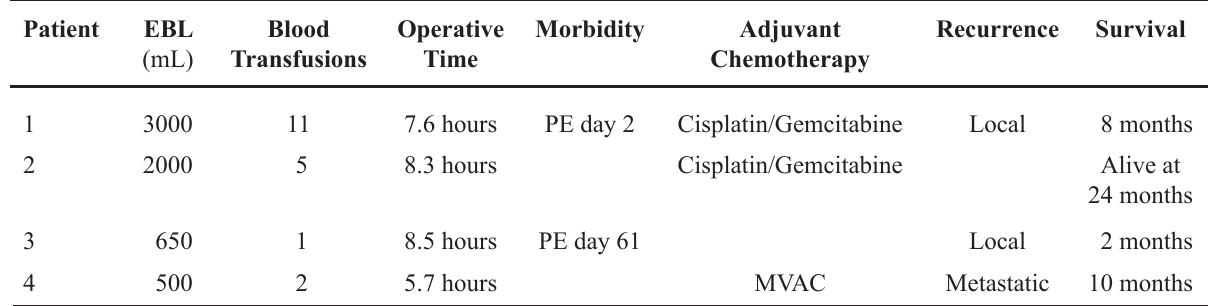
Table 1 – Treatment and outcome of patients with advanced urothelial carcinoma of the renal pelvis. Patient